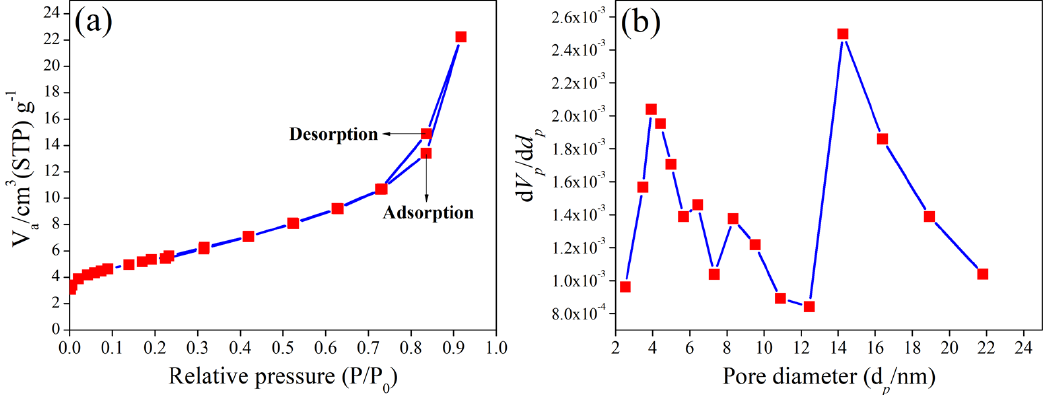
Figure 4. ( a ) N 2 adsorption–desorption isotherm and ( b ) BJH plot of the HAp-zirconia (HZ1) composite.